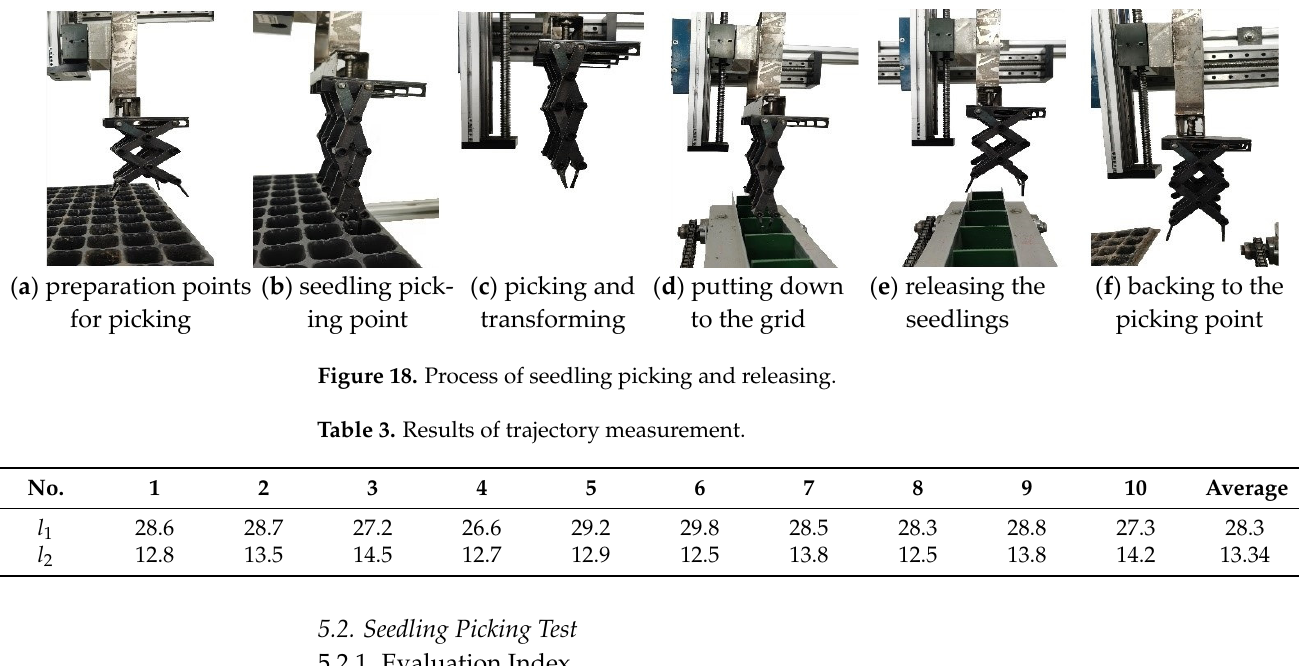
Figure 17. Movement trajectory diagram of seedling picking. At T 2 = 2.135 s, the device starts to take seedlings, and at T 3 = 3.33 s, the seedlings are picked; l 1 is the distance when the needle touches the substrate plane and l 2 is the vertical displacement of the movement.